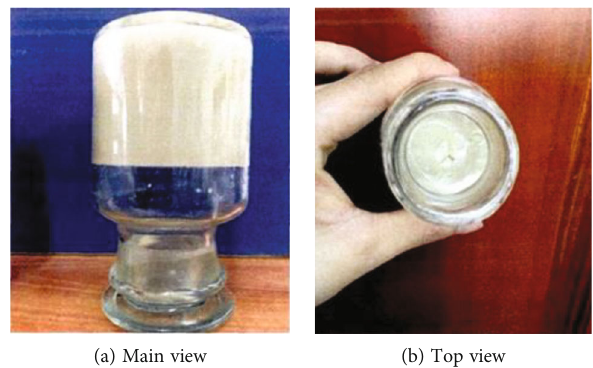
Figure 15: Preferred accelerator concentration tannin gel (accelerator 0.05%).